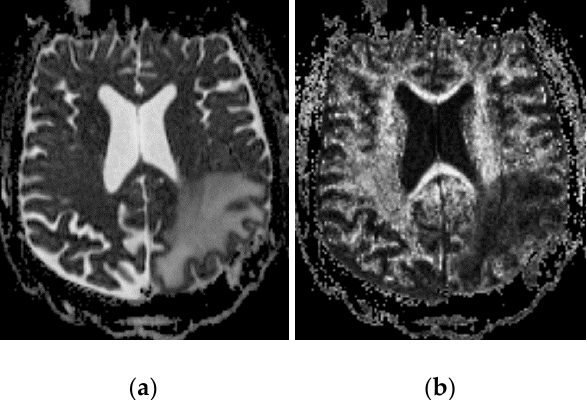
Figure 2. The expansion of white matter renders it isotropic (MR1-1 Patient 7): ( a ) average diffusion coefficient (ADC) map; and ( b ) fractional anisotropy (FA) map.